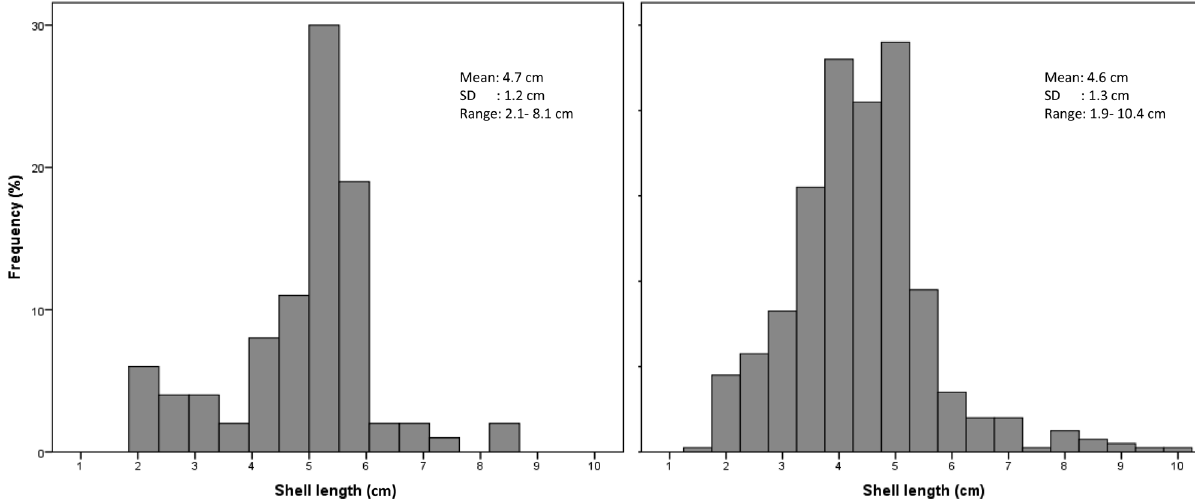
Fig. 5. Size frequency distribution of the hard clams caught by hand collecting ( n =109) (left) and hand dredging ( n =405) (right).